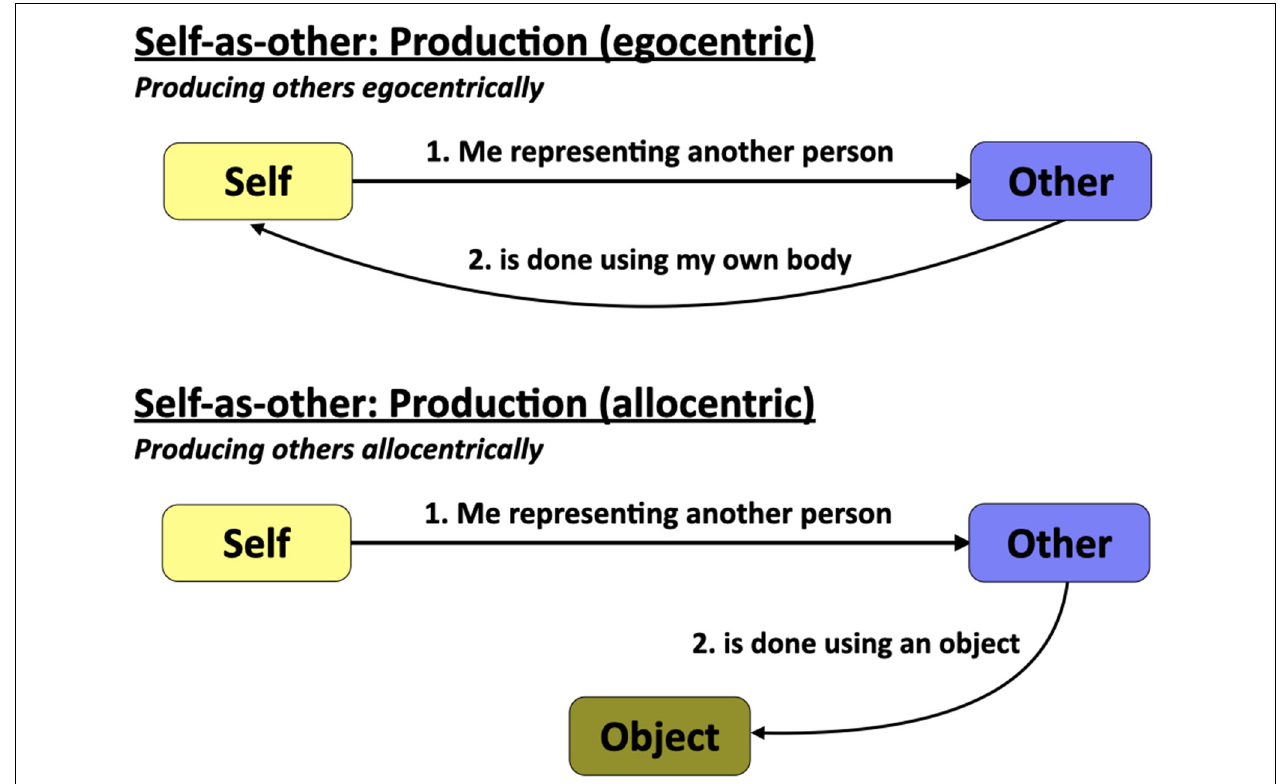
FIGURE 3 | The self-as-other mechanism. The principal self-as-other mechanism involves portraying others egocentrically through mimicry and acting (top panel). A second, though uncommon, mechanism involves producing others allocentrically (bottom panel). This can occur as a portrayal of another person using an object, for example a dummy in ventriloquism or an avatar in role-playing video games. The term “object” is used here to refer to either a physical or virtual representation of another